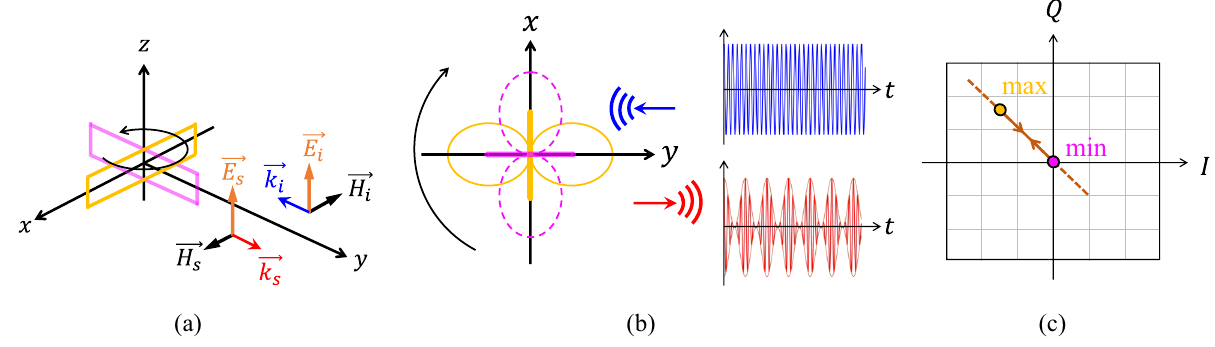
Figure 2. ( a ) Rotating rectangular loop in the monostatic scattering configuration. ( b ) Directional amplitude modulation induced on the backscattered wave by rotating loop. ( c ) The IQ constellation diagram of the demodulated received signal. The linear modulation path crosses the origin, and is limited in between the minimum and maximum of the reradiation pattern corresponding to the positions of the loop shown in ( b